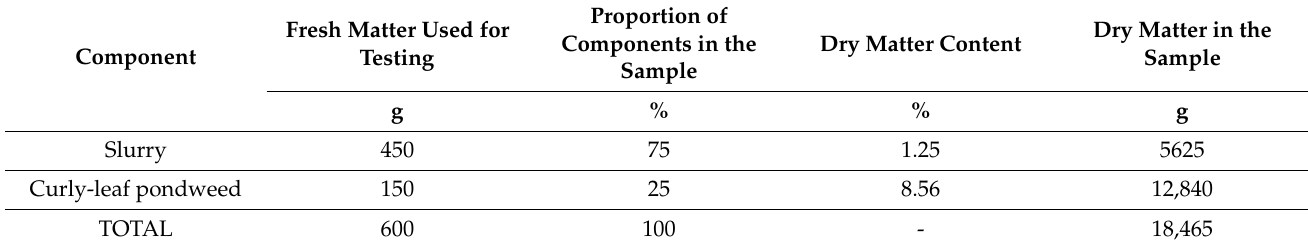
Table 2. Parameters of the slurry and pondweed mixture from Lake